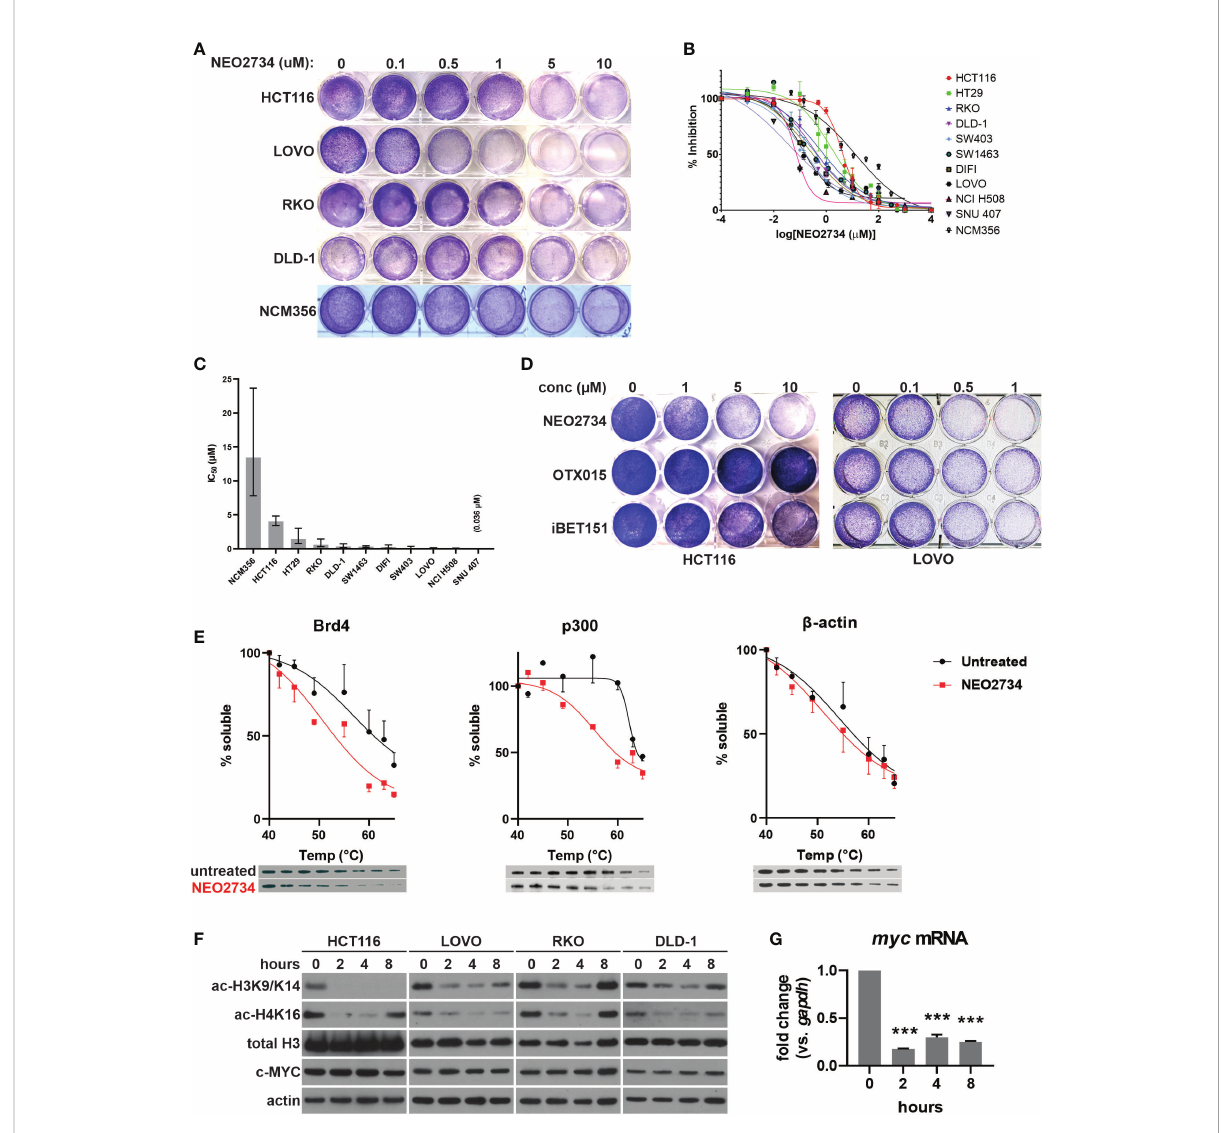
FIGURE 1 NEO2734 targets histone reader and writer to inhibit histone H3 and H4 acetylation in CRC. (A) Crystal violet staining of indicated cell lines were treated with NEO2734 for 72 hours. (B) MTS analysis of indicated cell lines treated with NEO2734. (C) Average IC 50 of each cell line. Error bars indicate 95% CI. (D) Crystal violet staining of HCT116 and LOVO cells treated with indicated drugs and concentrations for 72 hours. (E) Cellular thermal shift assay performed in HCT116 cells. Graphs shows mean soluble protein remaining after incubation at indicated temperatures, with error bars representing +/- SD (only one direction shown for each point for clarity). Representative western blot of each protein and temperature point shown below the graphs. Quanti fi cation derived from densitometric measured of 3 independent experiments, with density of each temperature point normalized to the density of a room temp control for that experiment. (F) Western blot of acetylated histones (H3K9/ K14, H4K16), total histones, and c-MYC in indicated cells over an 8-hour treatment course. (G) qRT-PCR of myc mRNA in HCT116 cells treated with NEO2734 10µM for the indicated timepoints, normalized to gapdh mRNA at each timepoint. ***p < 0.0005 compared to